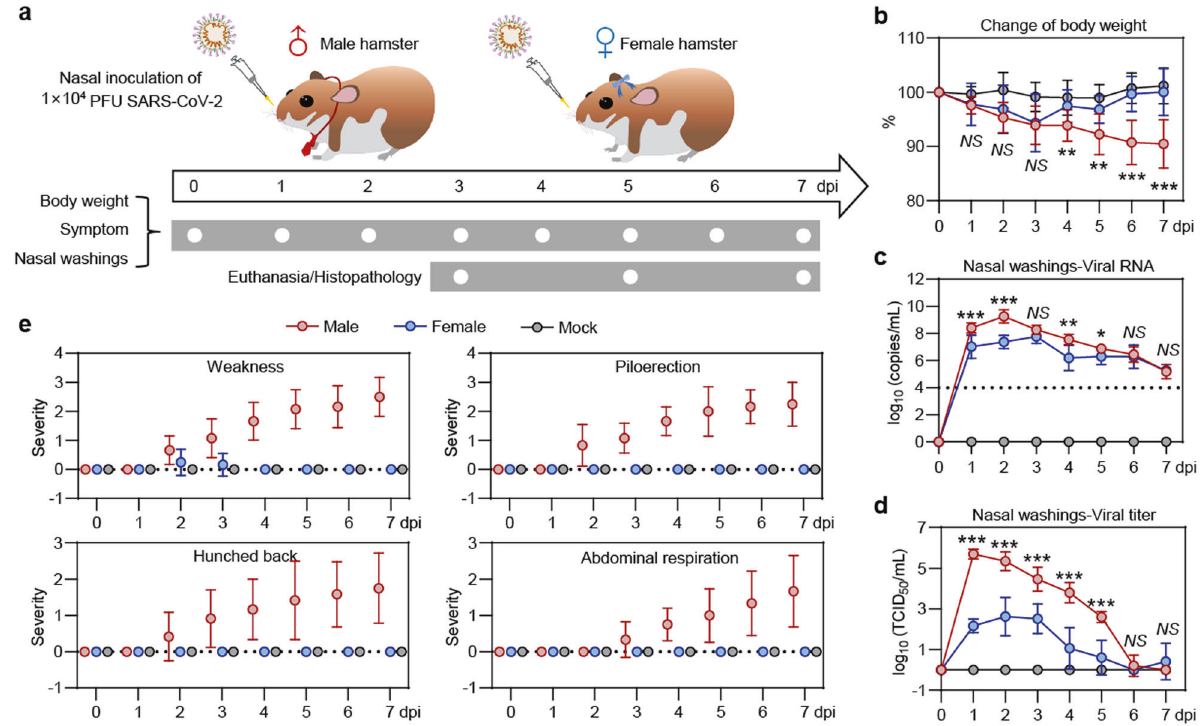
Fig. 1 Symptoms and viral shedding of male and female hamsters that were intranasally inoculated with SARS-CoV-2. a Schematic diagram of SARS-CoV-2 infection and animal operations. Male and female hamsters were intranasally inoculated with 10 4 PFU of SARS-CoV-2. Body weight and symptoms were daily examined. Nasal washings were daily collected. b Change of body weight ( n = 12/group). c PCR detection for viral RNA levels in nasal washings ( n = 6/group). d Titration for virus levels in nasal washings ( n = 6/group). e Daily observation of typical symptoms including weakness, piloerection, hunched back, and abdominal respiration ( n = 12/group). Each symptom was scored based on the severity of none (0), moderate (1), mild (2), severe (3), and very severe (4), respectively. Detailed data of individual animals were shown